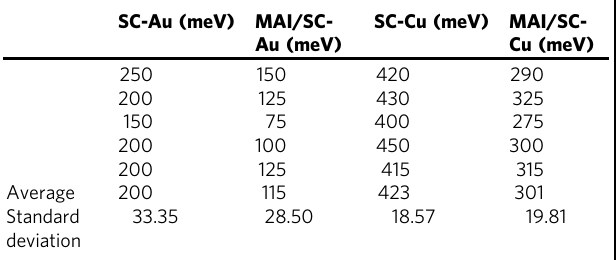
Table 1 Statistical table of MAPbI 3 single crystal surface potential before and after MAI treatment by using Au and Cu as reference electrodes.